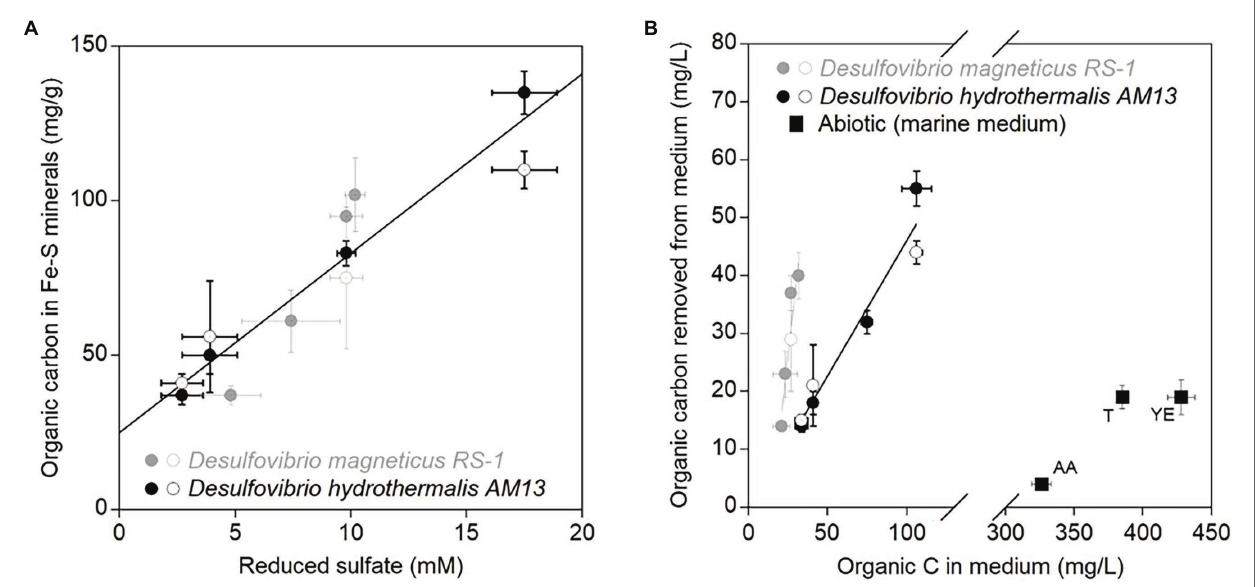
FIGURE 3 | (A) Average stabilized organic carbon contents (mg/g) in biogenic iron sulfide minerals as a function of average concentrations of reduced sulfate (mM). Black circles are data for marine strain Desulfovibrio hydrothermalis AM13, and gray circles are data for freshwater Desulfovibrio magneticus RS-1. Closed circles are from minerals precipitated in cultures grown with Fe(II) and open circles are from minerals precipitated in cultures to which Fe(II) was added after growth of SRB. Error bars represent ±one standard deviation. The linear regression is calculated for all data points ( R 2 = 0.89). (B) Average organic carbon concentrations (mg/L) removed from the medium in biotic and abiotic experiments by iron sulfide minerals as a function of average organic concentrations of carbon (mg/L) available in the medium. Black circles are data for marine Dh AM13, and gray circles are data for freshwater Dm RS-1. Closed circles are from minerals precipitated in cultures grown with Fe(II) and open circles are from minerals precipitated in cultures to which Fe(II) was added after growth of SRB. The black linear regression is calculated for all data points from experiments with marine Dh AM13 ( R 2 = 0.95) and the gray linear regression is calculated for all data points from experiments with marine Dm RS-1 ( R 2 = 0.89). Black squares are data from abiotic experiments to which organic mixtures have been used for co-precipitation of minerals: T, tryptone, YE, Yeast extract, and AA, Casamino acids. Error bars represent ±one standard deviation. Iron sulfide minerals have a higher affinity toward organic molecules in freshwater medium than in marine medium. Iron sulfide minerals also have a higher affinity toward cell biomass than organic mixtures in abiotic